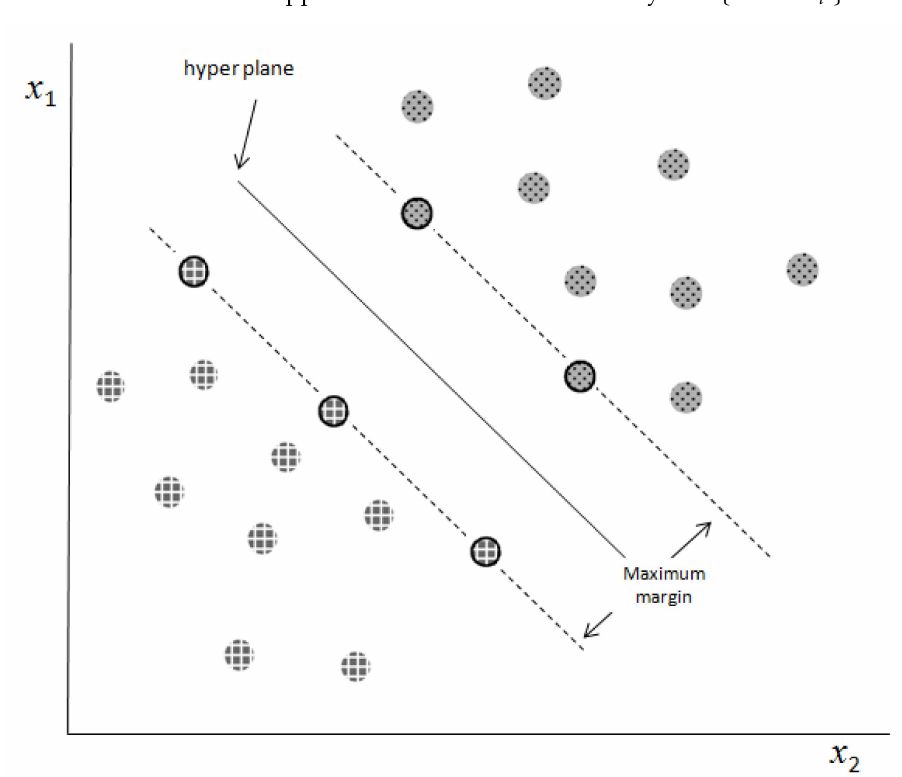
Figure 1. Support vectors and hyperplane selection. The support vectors demarcate the separat- ing hyperplane, which is represented by the continuous line, and define the margins, which are represented by dashed lines. The data in the two classes are separated by this